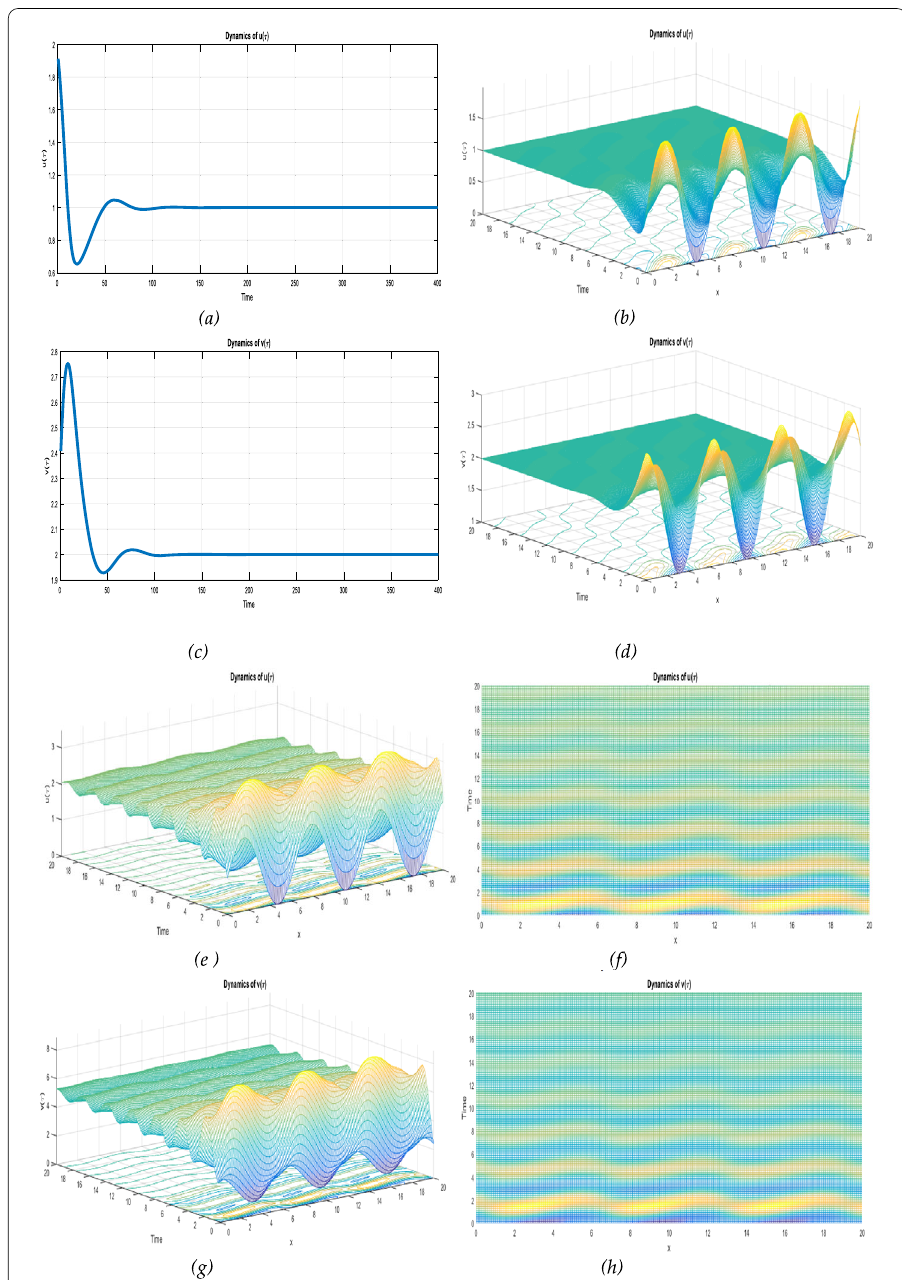
Figure 3 ( a )–( d ) Numerical solutions of system (32) using nonstandard finite difference scheme. Here, u 0 = 1 + sin( x ) and v 0 = 2 + cos( x ), with l = 5, m = 1, κ 1 = 0.01, and κ 2 = 0.01. (Top) The concentration of v ( τ ) is on the left while the concentration of v ( τ ) is on the right. (Bottom) The solutions v ( x , τ ) and u ( x , τ ) tend to the constant steady state. ( e )–( h ) Numerical solutions of system (32) sing nonstandard finite difference scheme. Here, u 0 = 1 + sin( x ) and v 0 = 2 + cos( x ), with l = 10, m = 5, κ 1 = 0.01, and κ 2 = 0.01. (Top) The solutions v ( x , τ ) and u ( x , τ ) tend to the spatially nonhomogeneous steady state. (Bottom) The projected views onto the x τ -plane at τ = 20 for v ( x , τ ) and u ( x , τ ). The stripe structure invades the nonhomogeneous steady states for v ( x , τ ) and u ( x , τ